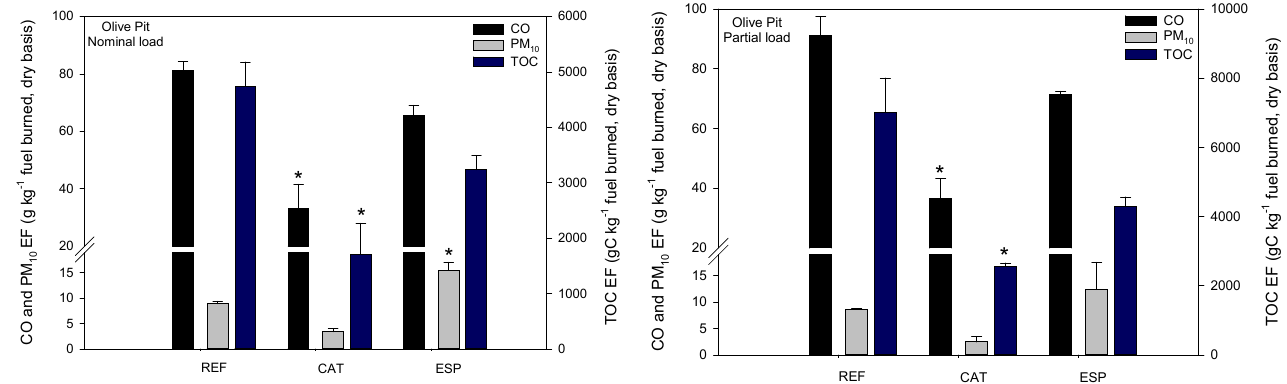
Figure 5. CO, TOC, and PM 10 emission factors from olive pit combustion at nominal and partial loads with or without catalytic converter (CAT) and electrostatic precipitator (ESP). Asterisks indicate a statistically significant difference compared to the reference condition (REF) ( p < 0.05; Kruskal–Wallis test).